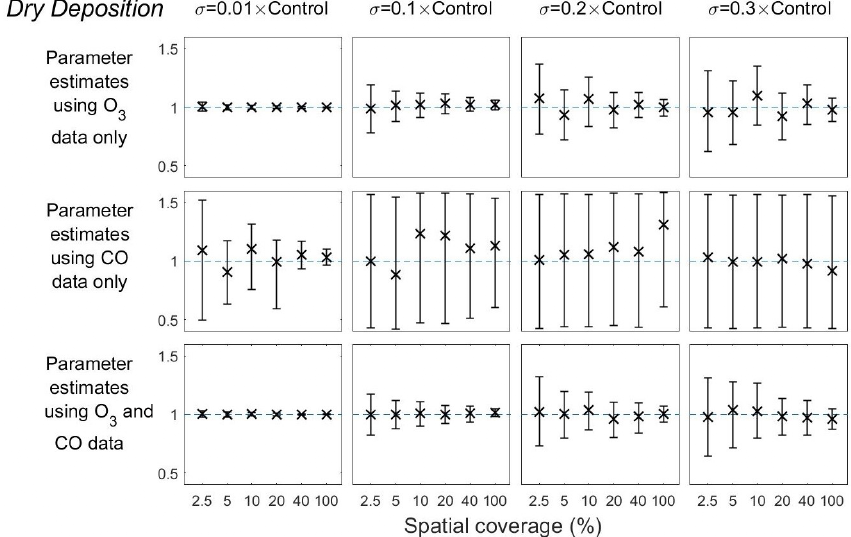
Figure 7. Means and 95% credible intervals of 3000 samples of the dry deposition scaling parameter from posterior distributions using the MCMC algorithm based on synthetic datasets from scenarios 1–72 (Table 1). Control refers to the FRSGC/UCI model control run surface concentration for each output point.